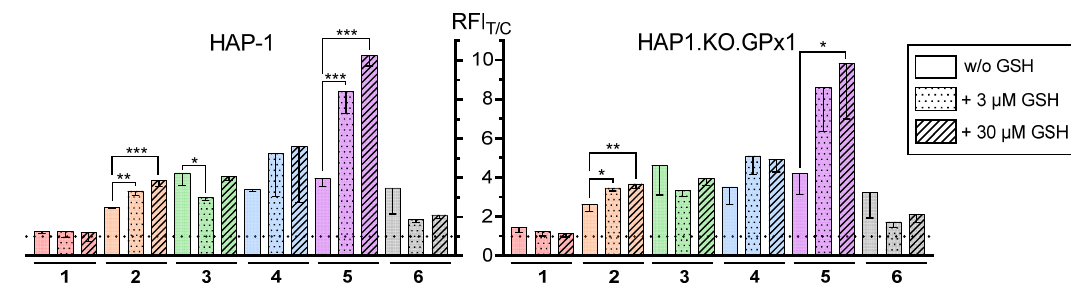
Figure 9. Relative intracellular levels of reactive oxygen species after an incubation for 15 min with pentathiepins (25 µ M) omitting or adding GSH to the treatment medium detected via flow cytometric DCFDA-based assay in HAP-1 and HAP-1.KO.GPx1. Solvent only was used as negative control (set to 1, dashed line) and treatment conditions with either no, 3, or 30 µ M of GSH were related to it. Data are displayed as mean and SD, and statistical analysis was performed in Prism 7 by one-way ANOVA and Dunnett’s multiple comparisons post hoc test. n ≥ 3 independent experiments, * p < 0.05, ** p < 0.01, *** p < 0.001.